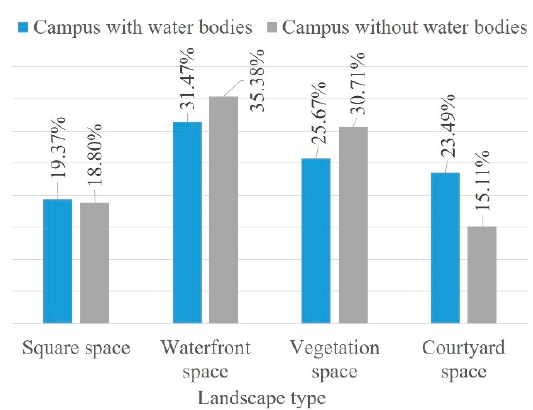
Figure 3. Comparison of waterfront space preference.